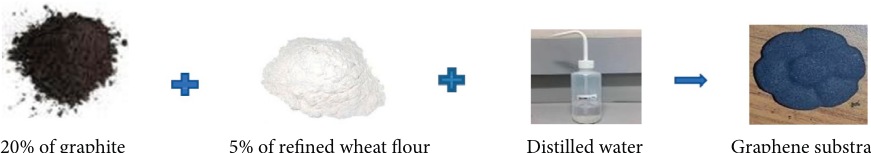
Figure 1: Preparation of graphene-refined wheat flour substrate.